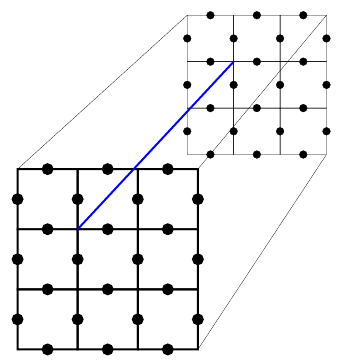
Figure 4: Illustration of a non-local “line"-operator corresponding to the product of σ z along the blue line assuming periodic boundary i